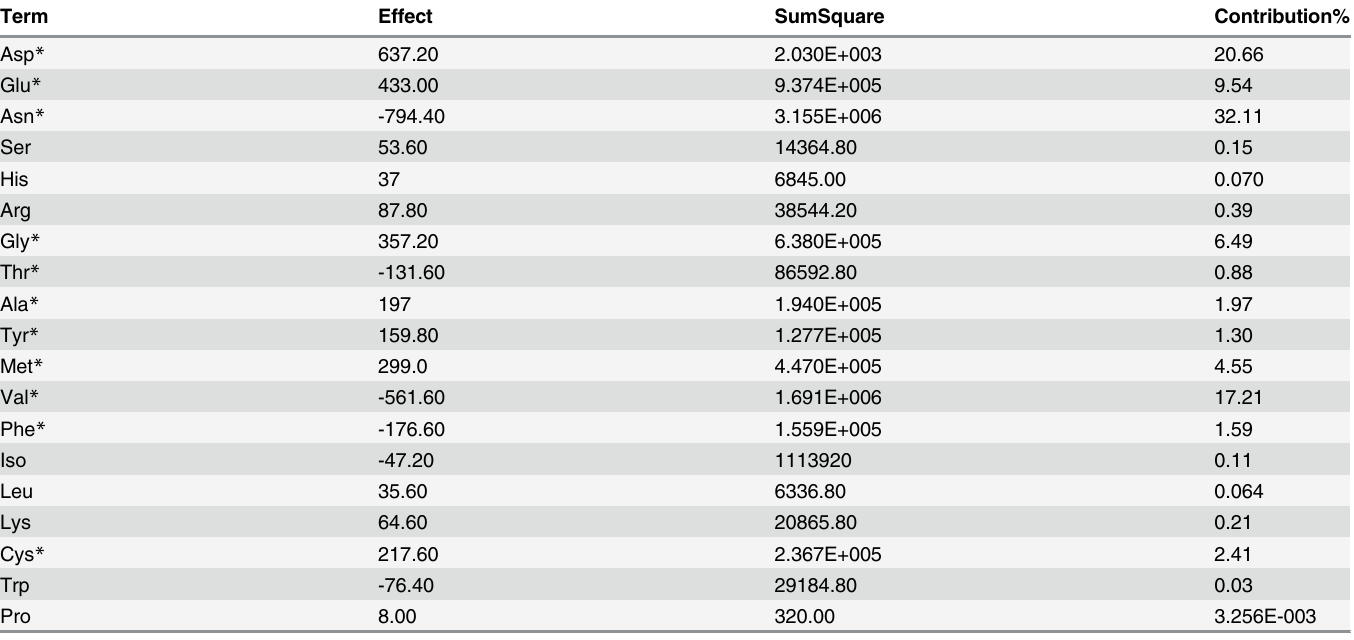
Table 4. The effects of amino acids on Integral Viable Cell Concentration, the effect parameter is the change in IVCC as the amino acid concentra- tion changes from its low level to its high level. SumSquare is the sum of squared deviations from the mean of the effect parameter for each amino acid. Contribution% determines the individual amino acid contribution to IVCC response.